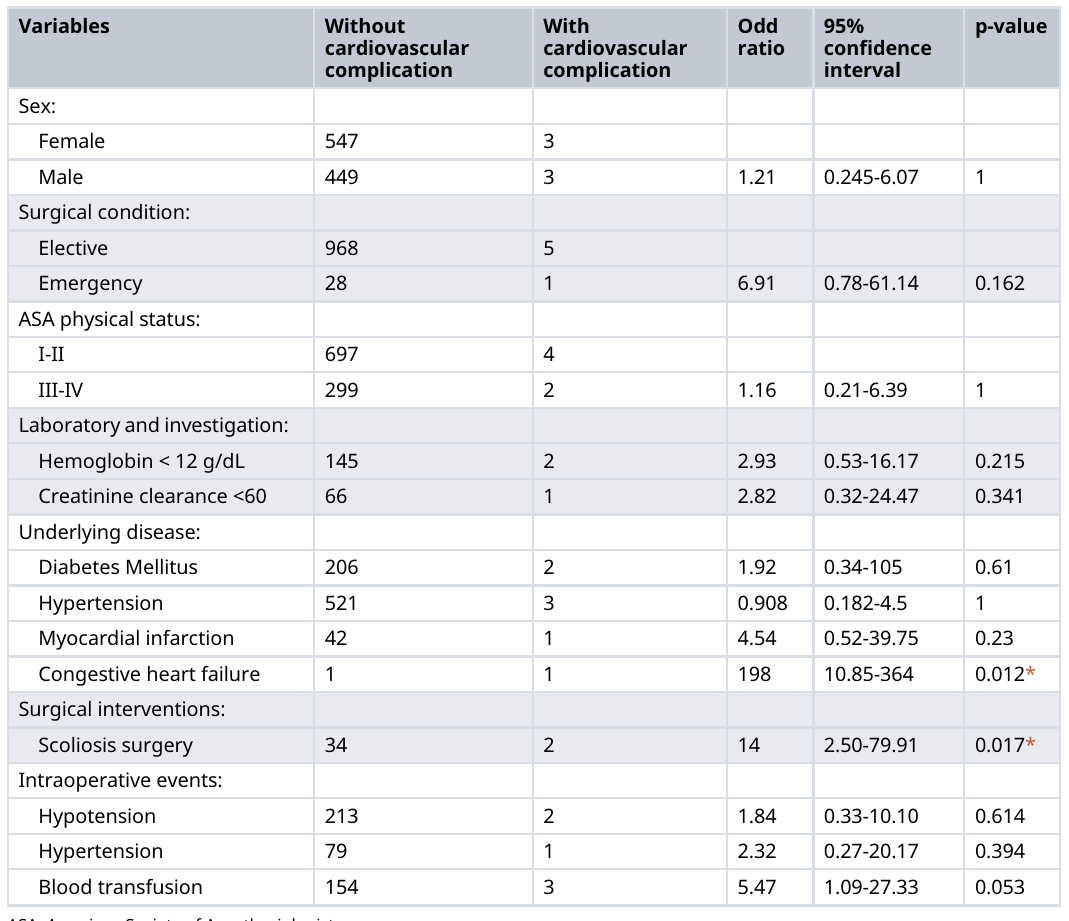
Table 2. Univariate Analysis of the risk for cardiovascular complications in spine surgery.